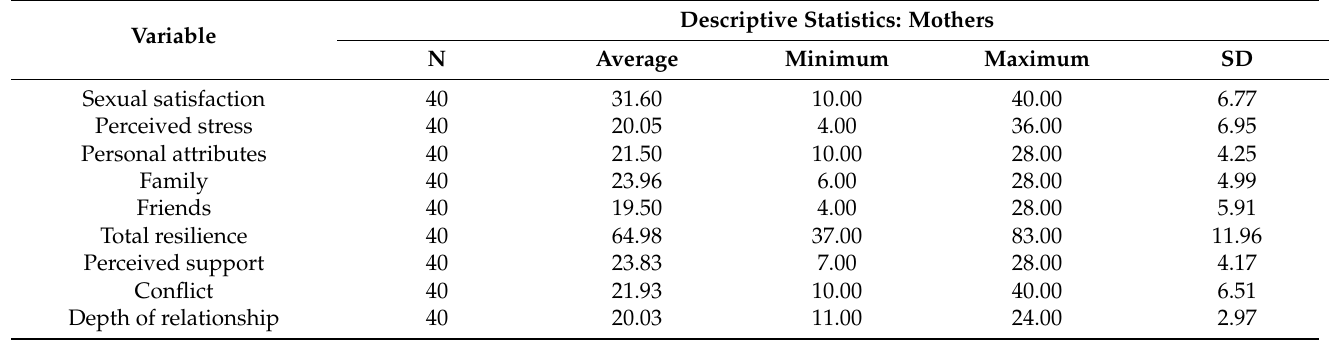
Table 3. Distribution of results (descriptive statistics)—early- stage mothers.